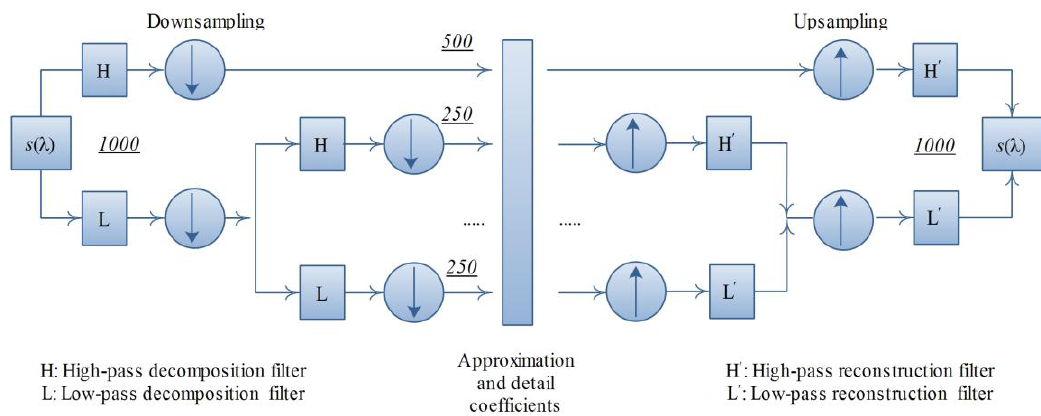
Figure 2. Decomposition and reconstruction processes of discrete wavelet